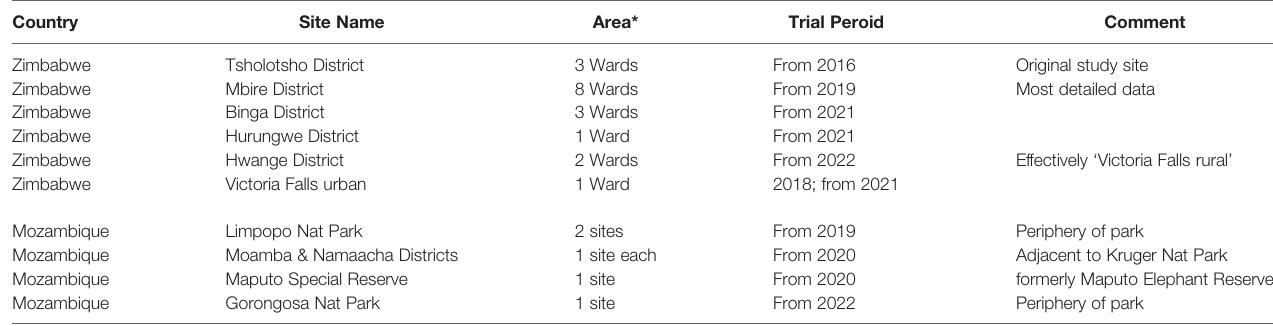
TABLE 1 | List of HEC study sites in Zimbabwe and Mozambique.